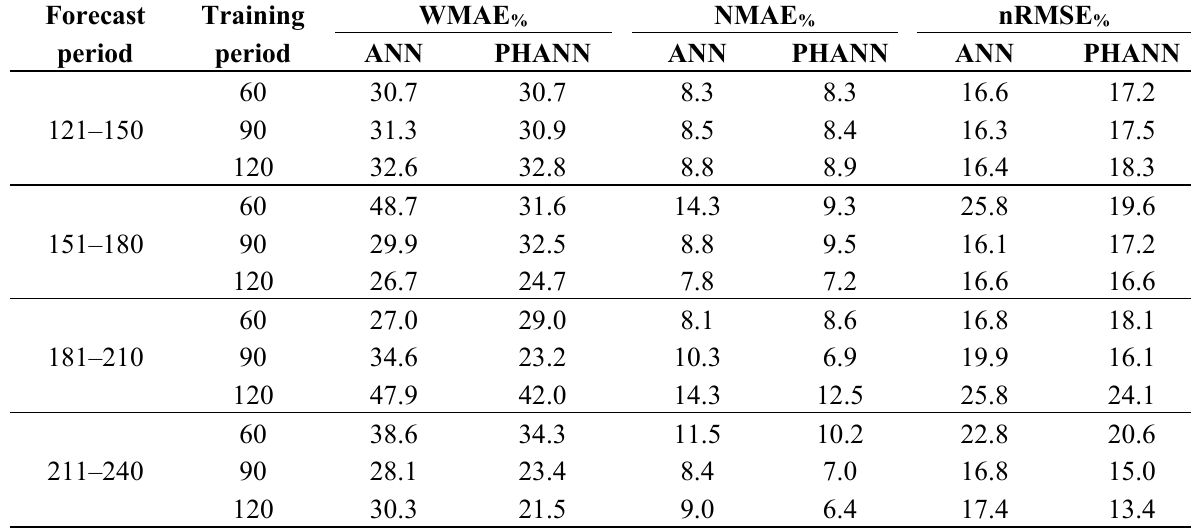
Table 1. Errors as a function of the size of the training set and of the different period of the year. Forecast period